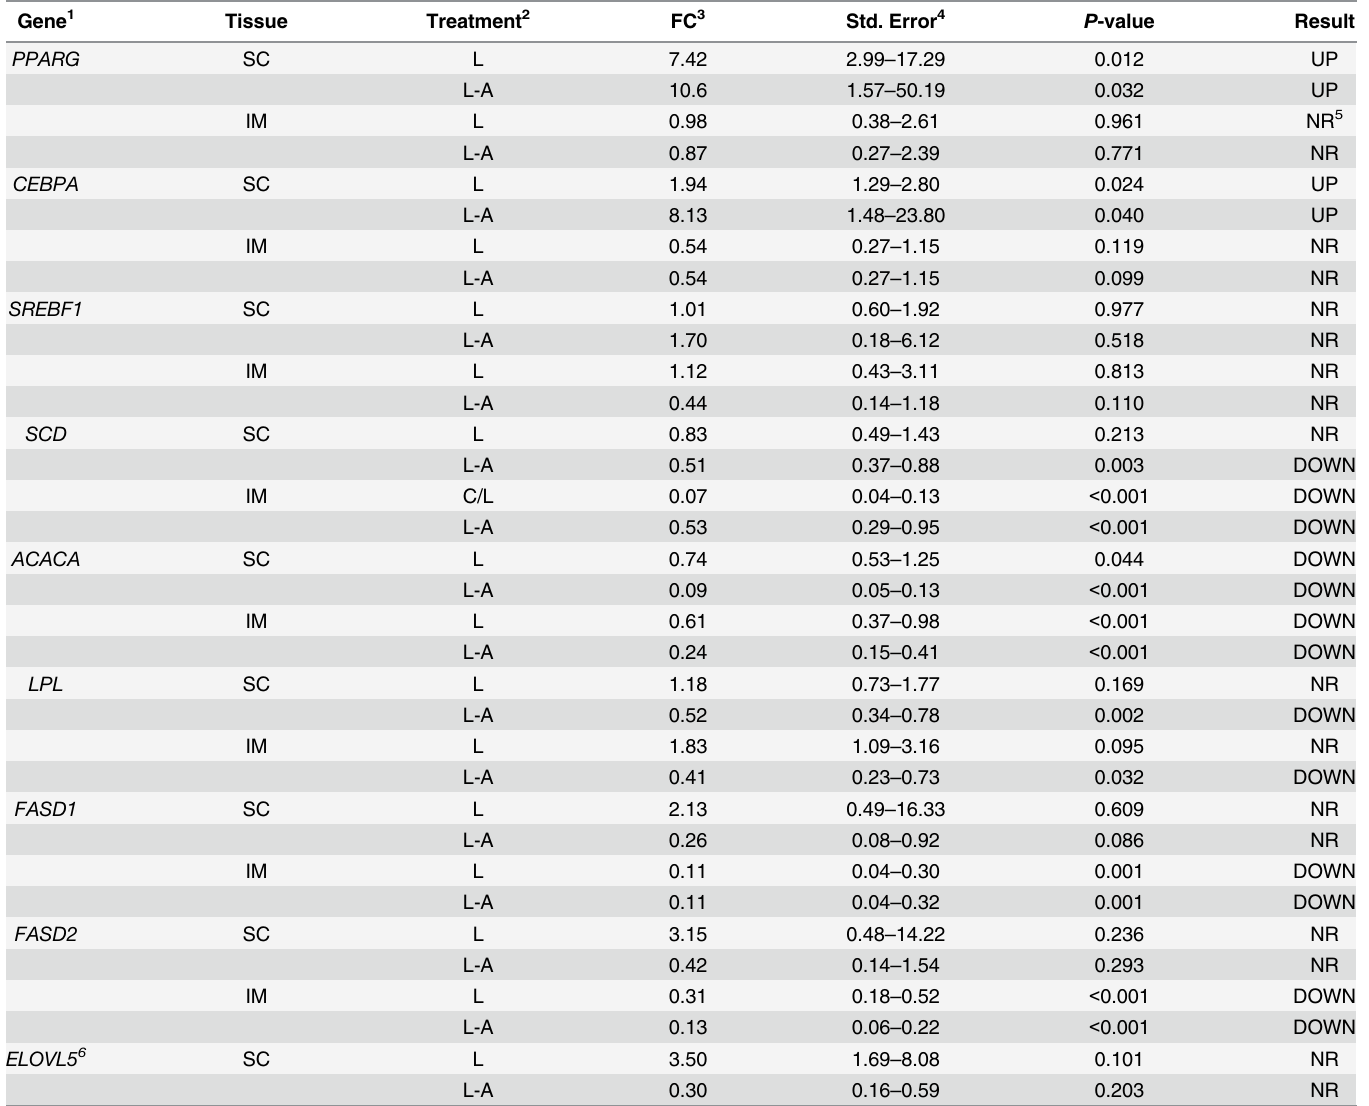
Table 6. Effects of addition of linseed or linseed and marine algae to the diet on relative mRNA expression of lipid metabolism genes in subcutane- ous and intramuscular adipose tissues of Navarra breed lambs. Gene